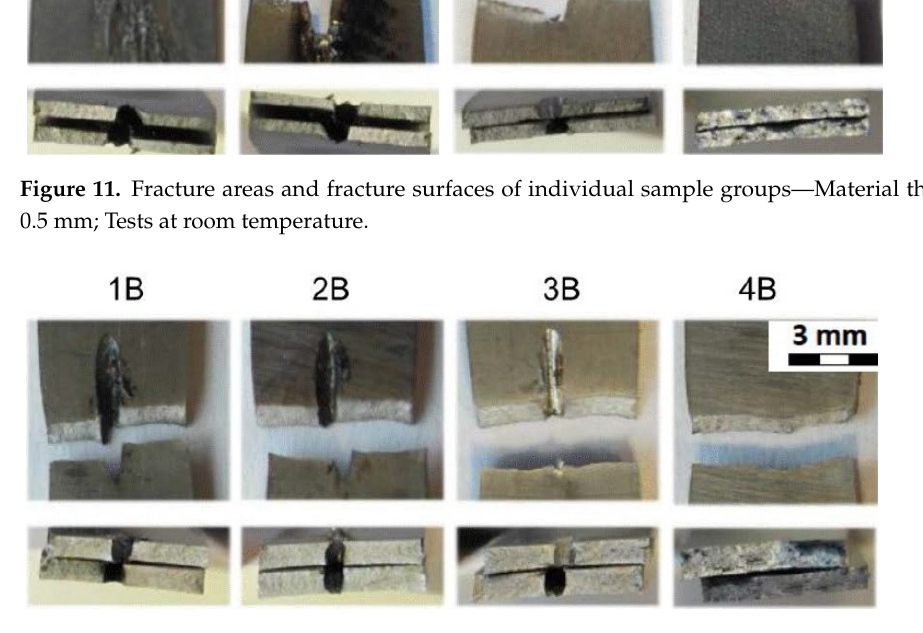
Table 7. Average values of mechanical properties—Inconel 718; material thickness 1.0 mm; tests at room temperature.